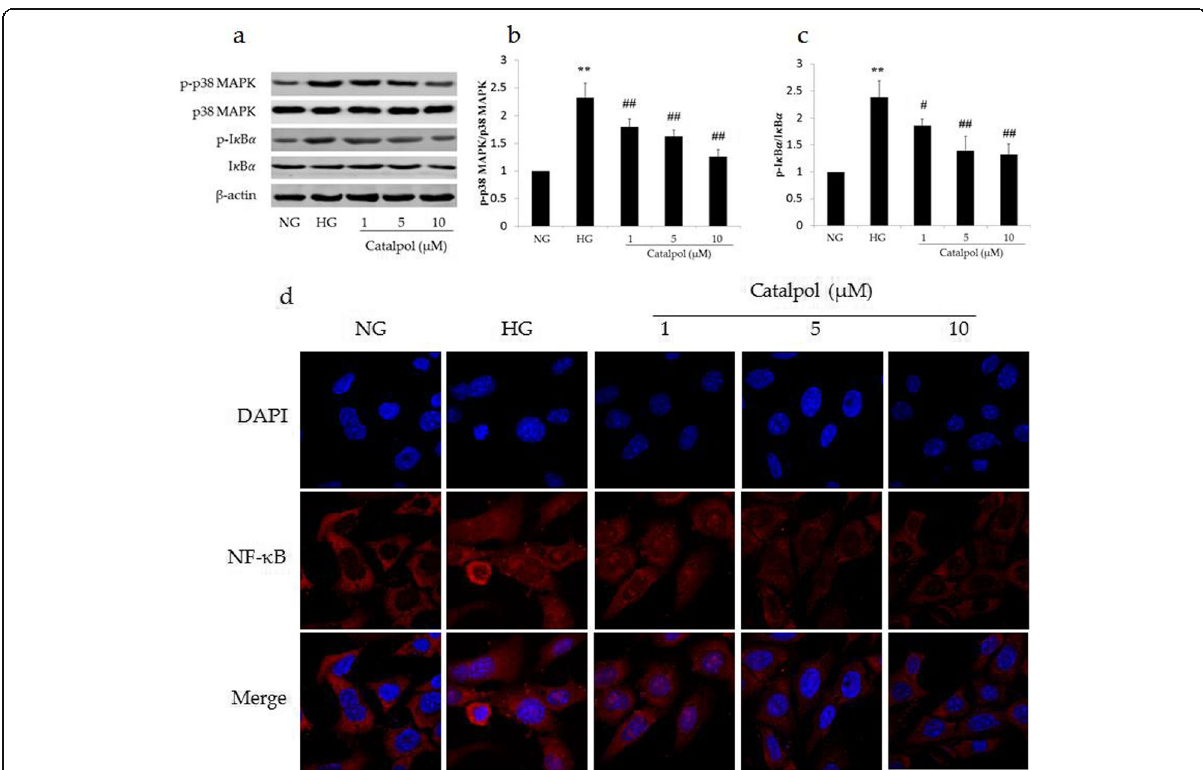
Fig. 7 Effect of catalpol on the ROS-mediated p38 MAPK/NF- κ B signaling pathway in HG-induced podocyte injury. a p38 MAPK, p-p38 MAPK, I κ B α and p-I κ B α detections in podocytes by western blotting. b Ratio of p-p38 MAPK/p38 MAPK in podocytes ( n = 3). c Ratio of p-I κ B α /I κ B α in podocytes ( n = 3). d Immunofluorescence staining for NF- κ B. Data are presented as the mean ± SD. ** p < 0.01 vs NG, # p < 0.05, ## p < 0.01 vs